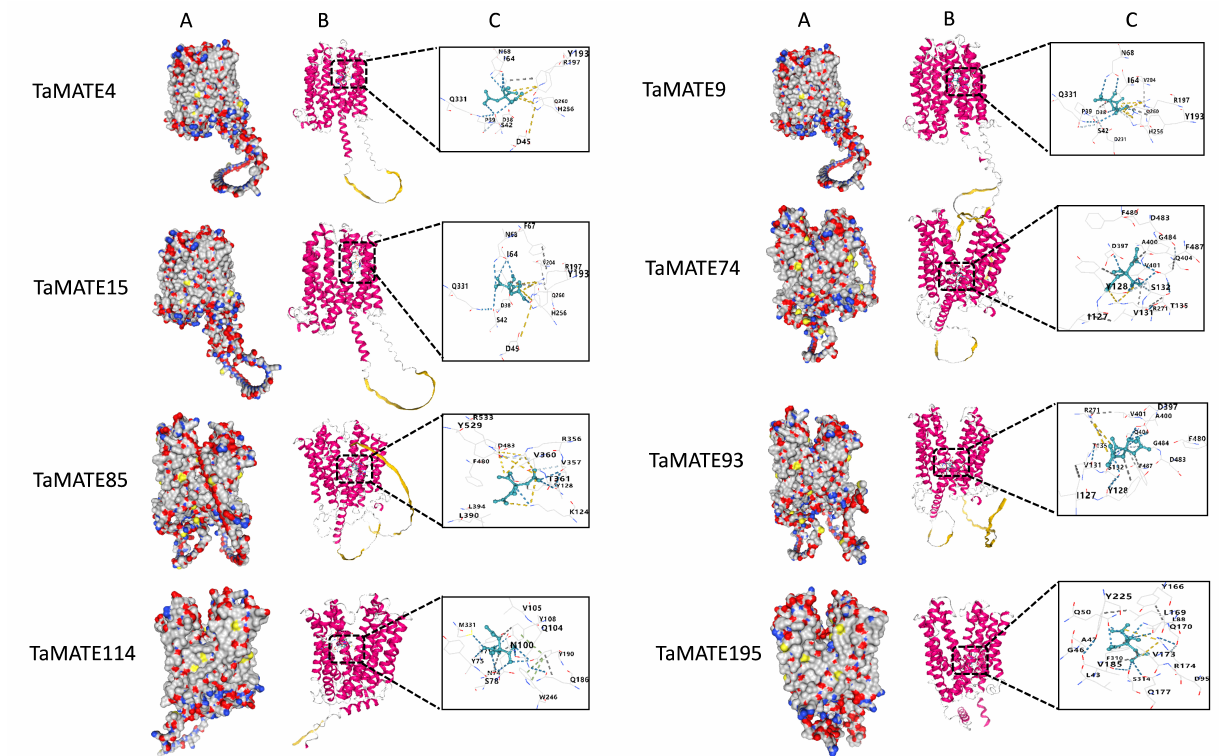
Figure 8. The docking modes of citrate in TaMATE4, TaMATE9, TaMATE15, TaMATE74, TaMATE85, TaMATE93, TaMATE114 and TaMATE195 transporters. ( A ) The binding model of citrate with TaMATEs. ( B ) The binding poses of citrate in different MATE transporters. ( C ) The binding site of citrate in different TaMATE transporters. The model building of 3D structure in wheat MATE protein by